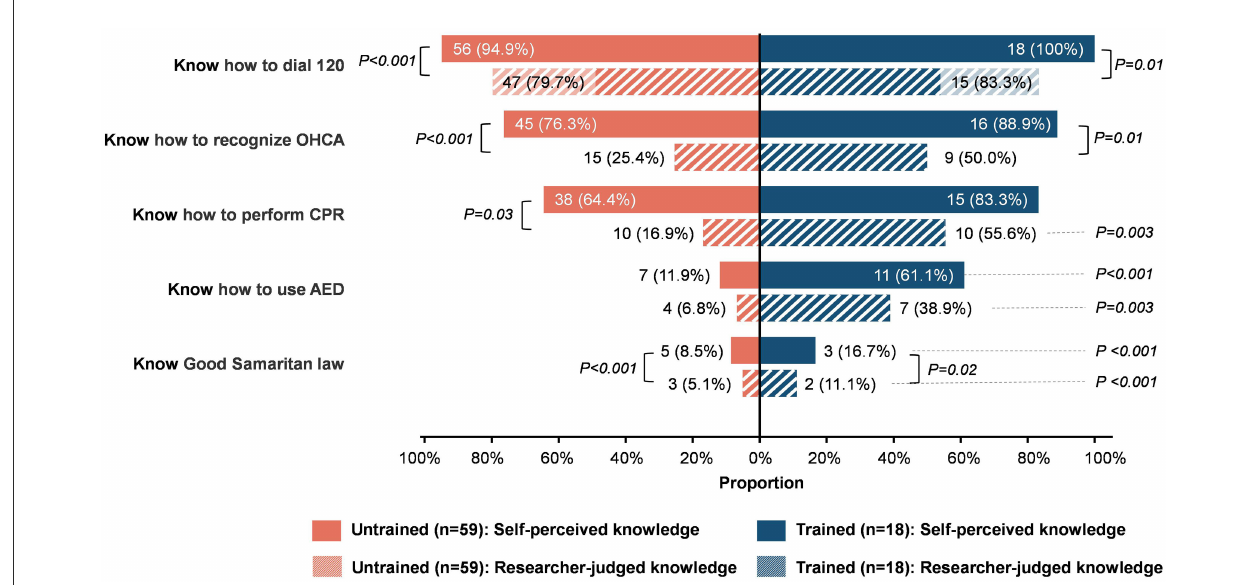
FIGURE2 Demand-side respondents’ self-perceived and researcher-judged first-aid knowledge. Values are shown as proportions. 120, the universal number for emergency care and first aid in China; OHCA, out-of-hospital cardiac arrest; CPR, cardiopulmonary resuscitation; AED, automated external